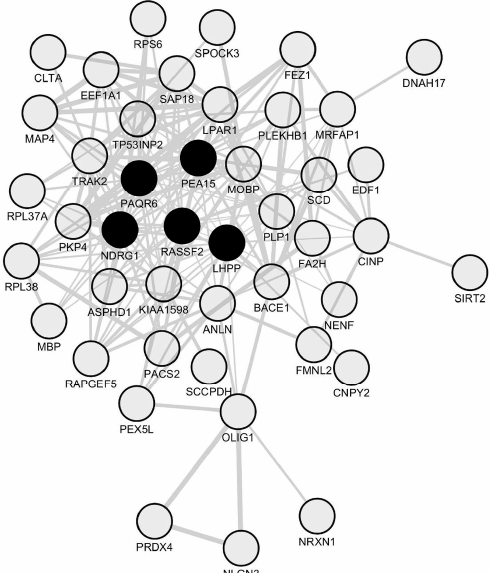
Figure 4. Network of co-downregulated genes in spinal cord periplaques. A co-expression network was generated with the set of genes that are constantly downregulated in periplaques as compared to adjacent normal-appearing white matter (NAWM). In this co-expression module, hubs were defined as genes (nodes) being connected to at least half of the total number of genes (nodes) forming the network. Five hub genes (black-filled nodes) were identified, namely NDRG1 ( N -myc downstream regulated 1), PEA15 (phosphoprotein enriched in astrocytes 15), RASSF2 (Ras association domain family member 2), PAQR6 (progestin and adipoQ receptor family member 6) and LHPP (phospholysine phosphohistidine inorganic pyrophosphate phosphatase). Genes are designated by their gene symbols. Full names of functionally-relevant genes are provided in Table 1.